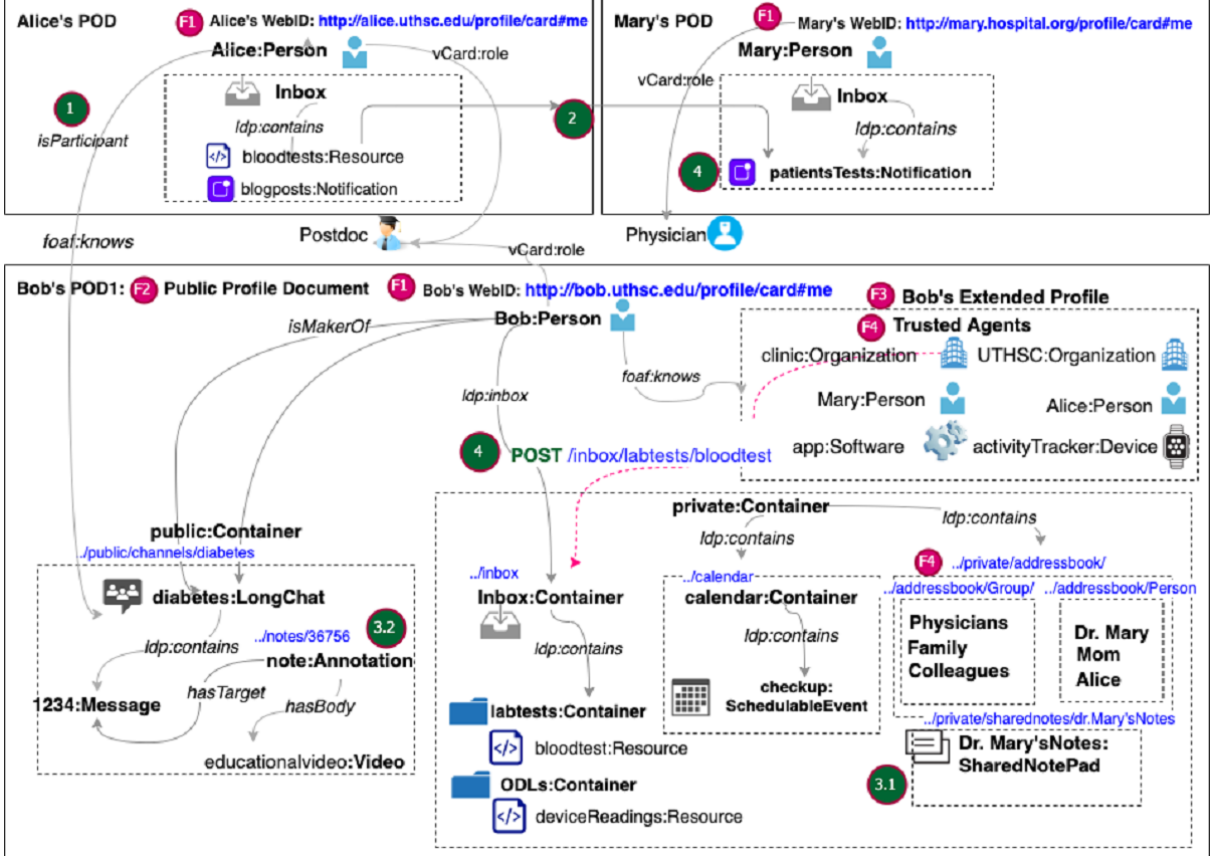
Figure 2. Main PHL features that meet some of the patients' requirements (Table 2) demonstrated through the PODs of Alice, Bob, and Mary. Bob’s POD contains his main profile document in RDF-based KG representation. Social interactions within the PHL ecosystem include: (1) Alice and Mary can subscribe to Bob’s channel using their WebIDs. (2) Alice can share her lab tests by pushing them to Mary’s inbox. (3.1) Alice can share a notepad with Mary to discuss her lab results. (3.2) Alice can add annotations or comments to message content in Bob’s diabetes channel. (4) Software from a clinic or other provider can share test results with Alice by performing a POST Web API operation on the unique URI of her inbox. POD: personal online data store.